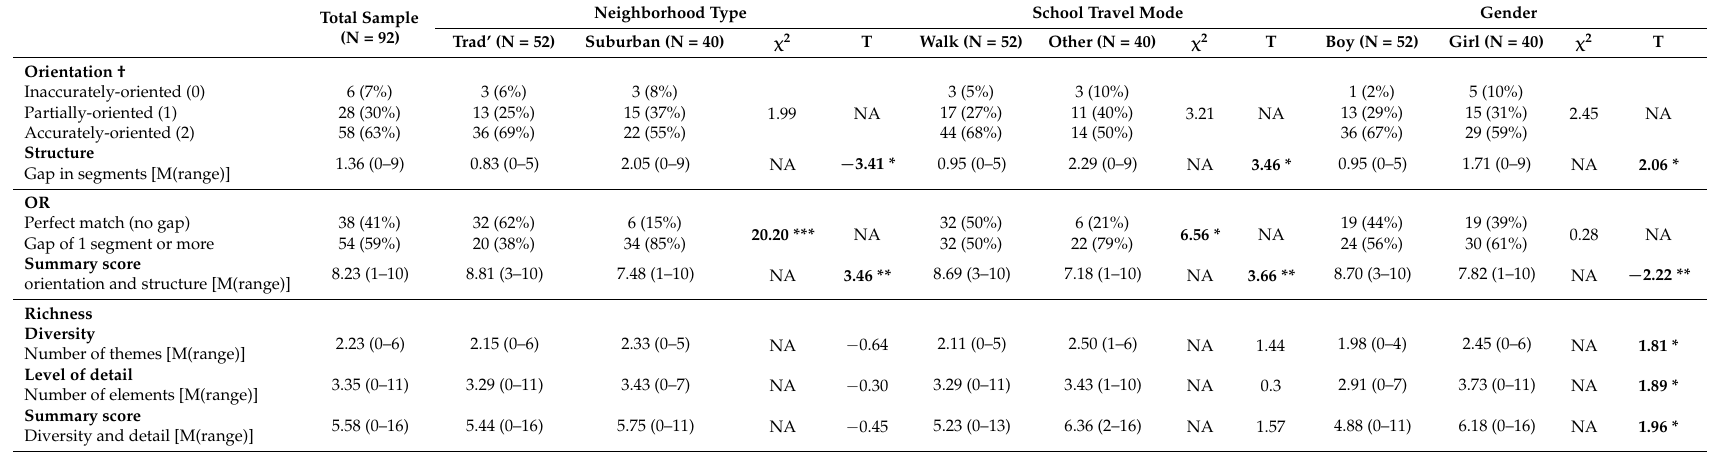
Table 3. Sketch map scores in the study sample by neighborhood type, school travel mode and